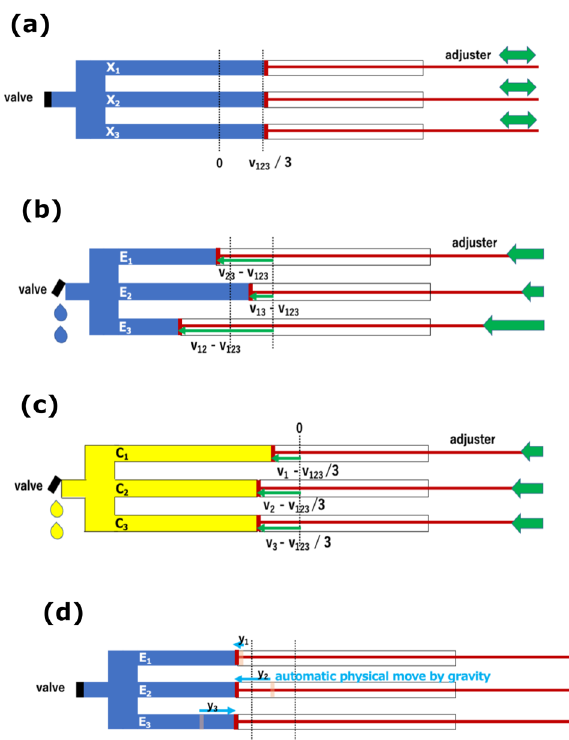
Fig. 4 Fair distribution method utilising physics in the game of characteristic function form. a Equally divide the pro fi t of coalition with all ( v (1, 2, 3)). That is, x 1 + x 2 + x 3 = v (1, 2, 3). Here, x i is the allocated pro fi t for i . b For each i , add the pro fi t of coalition { j , k } ( + v ( j , k )) and subtract the pro fi t of coalition with all ( − v (1, 2, 3)). For each i , mark the present position as the initial position of displacements y i . Here, x i = y i + v (1, 2, 3)/3,